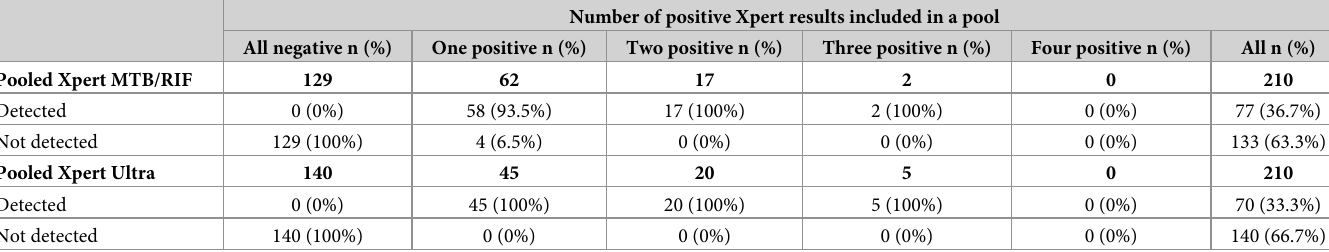
Table 2. Distribution of positive individual samples among pooled results, by Xpert